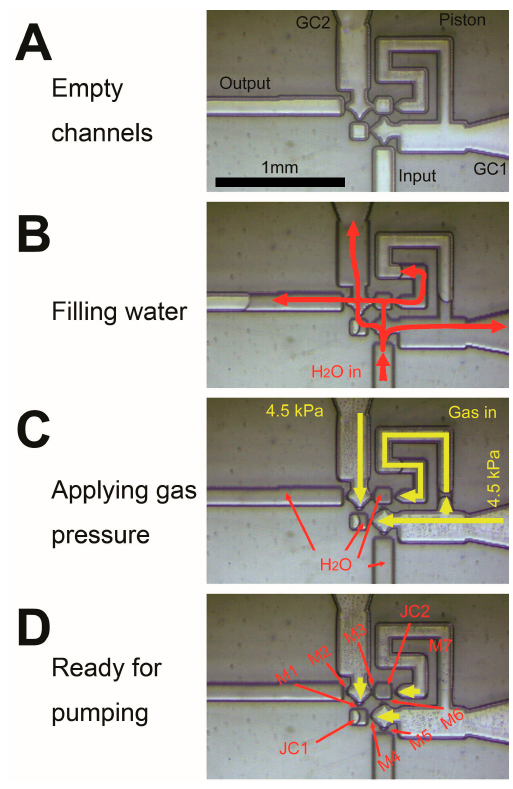
Figure 2. An initial preparing of a pump. The empty channels ( A ) are filled with water from the input channel (( B ) see red arrows). When high gas pressure applied (( C ) 4.5 kPa), water in control channels (GC1 and GC2) and in the piston are driven into liquid channels and the two joint chambers (( D ) JC1 and JC2) until MISTAs (M1–M7) stop the liquid-gas interface. GC1: Gas control 1; GC1: Gas control 2.